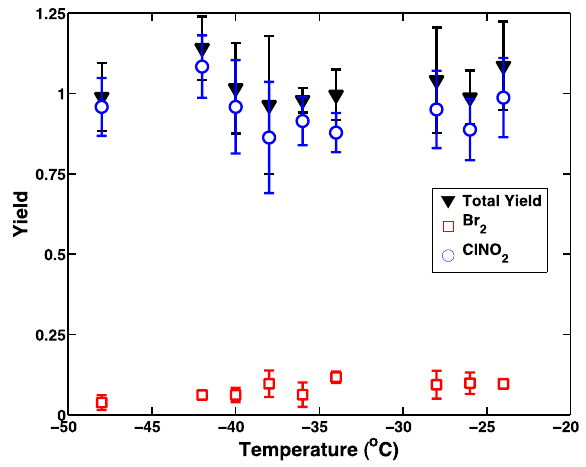
Fig. 5. Halogen product yields are plotted as a function of ice tem- perature. The error bars are one sigma standard deviations in the temperature bins. The same synthetic seawater solution (salinity of 35 parts per thousand and Cl:Br of 650:1) was used to make the ice in all cases. No significant changes in halogen products is observed across the temperature range studied, as is consistent with the com- petitive mechanism (shown in Fig. 3) because the Cl:Br mole ratio in the corresponding brines theoretically remains above ∼